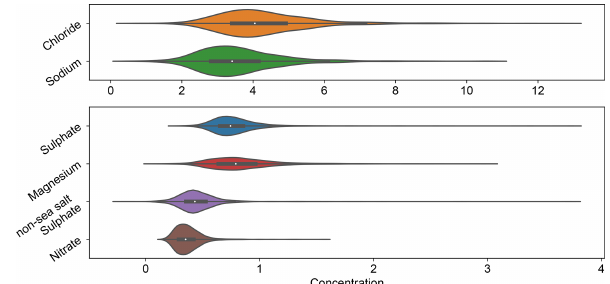
Figure 8. Violin plots showing the median, interquartile range and distribution of the annually averaged trace ions. The chloride and sodium records are separated only for illustrative purposes so that their higher concentrations do not dominate the plots of the other ions.